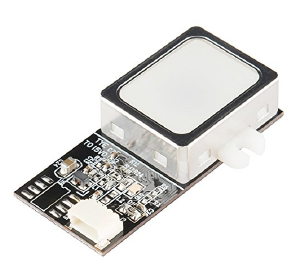
Figure 2. Fingerprint Scanner